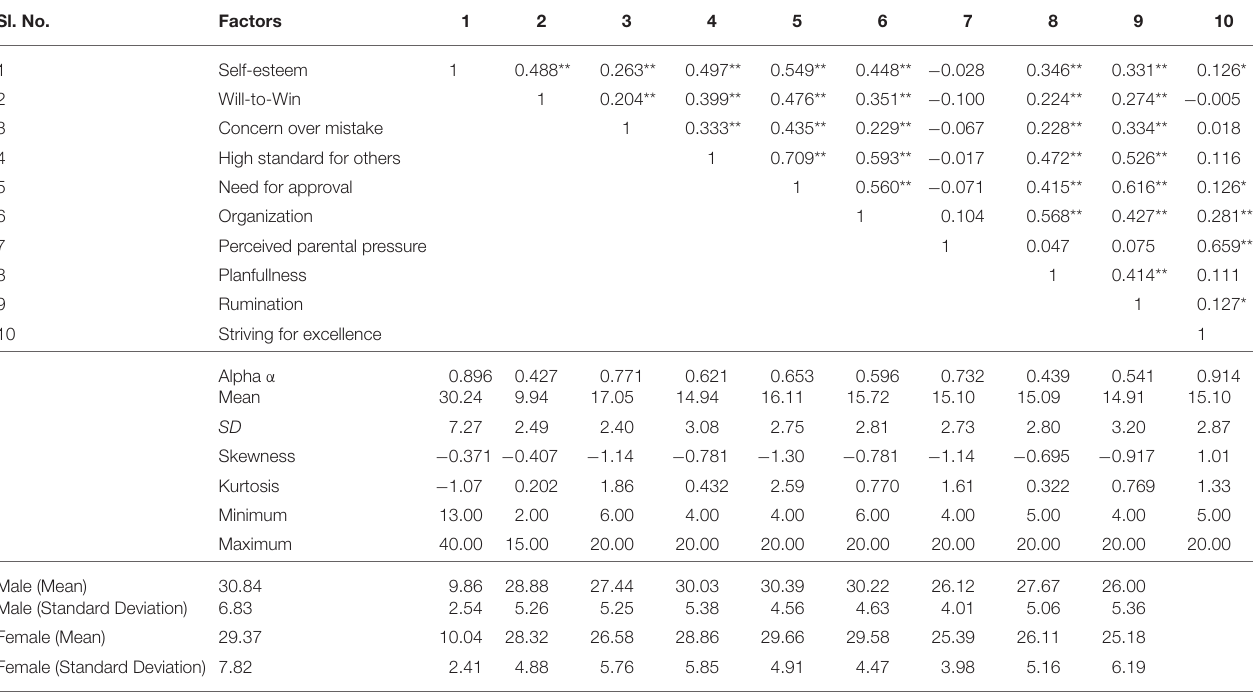
TABLE 2 | Descriptive statistics, intercorrelations, and reliability.